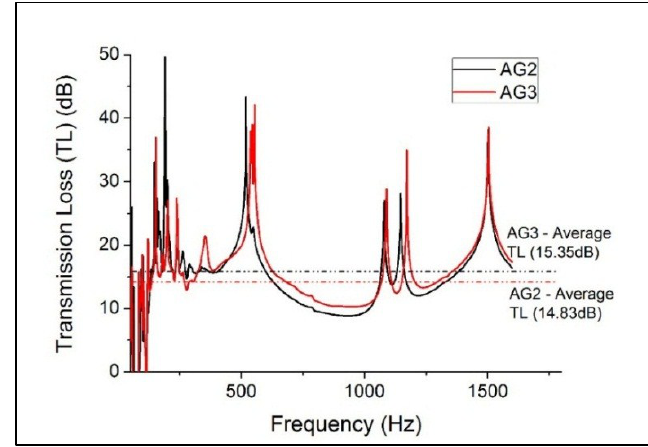
Figure 3. Evaluation of TL for AG2 and AG3 via proposed “Inferential Method” using two-microphone impedance tube.